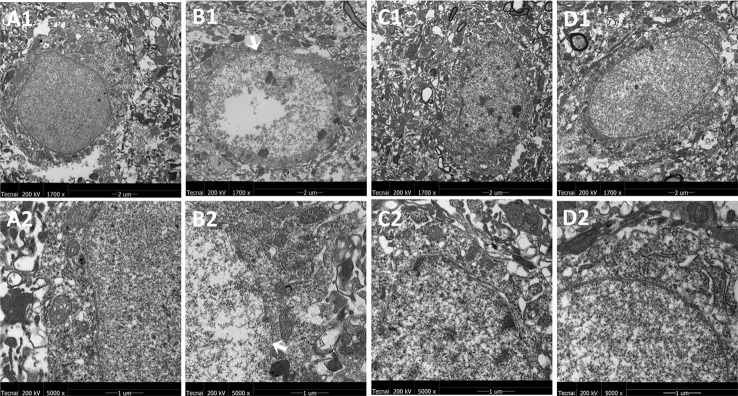
Mitochondria abnormalities identified in the striatum region by transmission electron microscope. n = 3 for each group. Representative image of each group was viewed at 1,700× (scale bar = 2 μm) and 5,000× (scale bar = 1 μm) magnifications to detect changes in the striatum mitochondria. Abbreviations: A1: Representative image of low magnification (1,700×) image from control group. B1: Representative image of low magnification (1,700×) image from model group; The white arrow indicates the rupture of the double membrane. C1: Representative image of low magnification (1,700×) image from FLX group; D1: Representative image of low magnification (1,700×) image from JPZDD group. A2: Representative image of high magnification (5,000×) image from control group. B2: Representative image of high magnification (5,000×) image from model group; “Disrupted” membrane is shown by the white arrow. C2: Representative image of high magnification (5,000×) image from FLX group; D2: Representative image of high magnification (5,000×) image from JPZDD group.